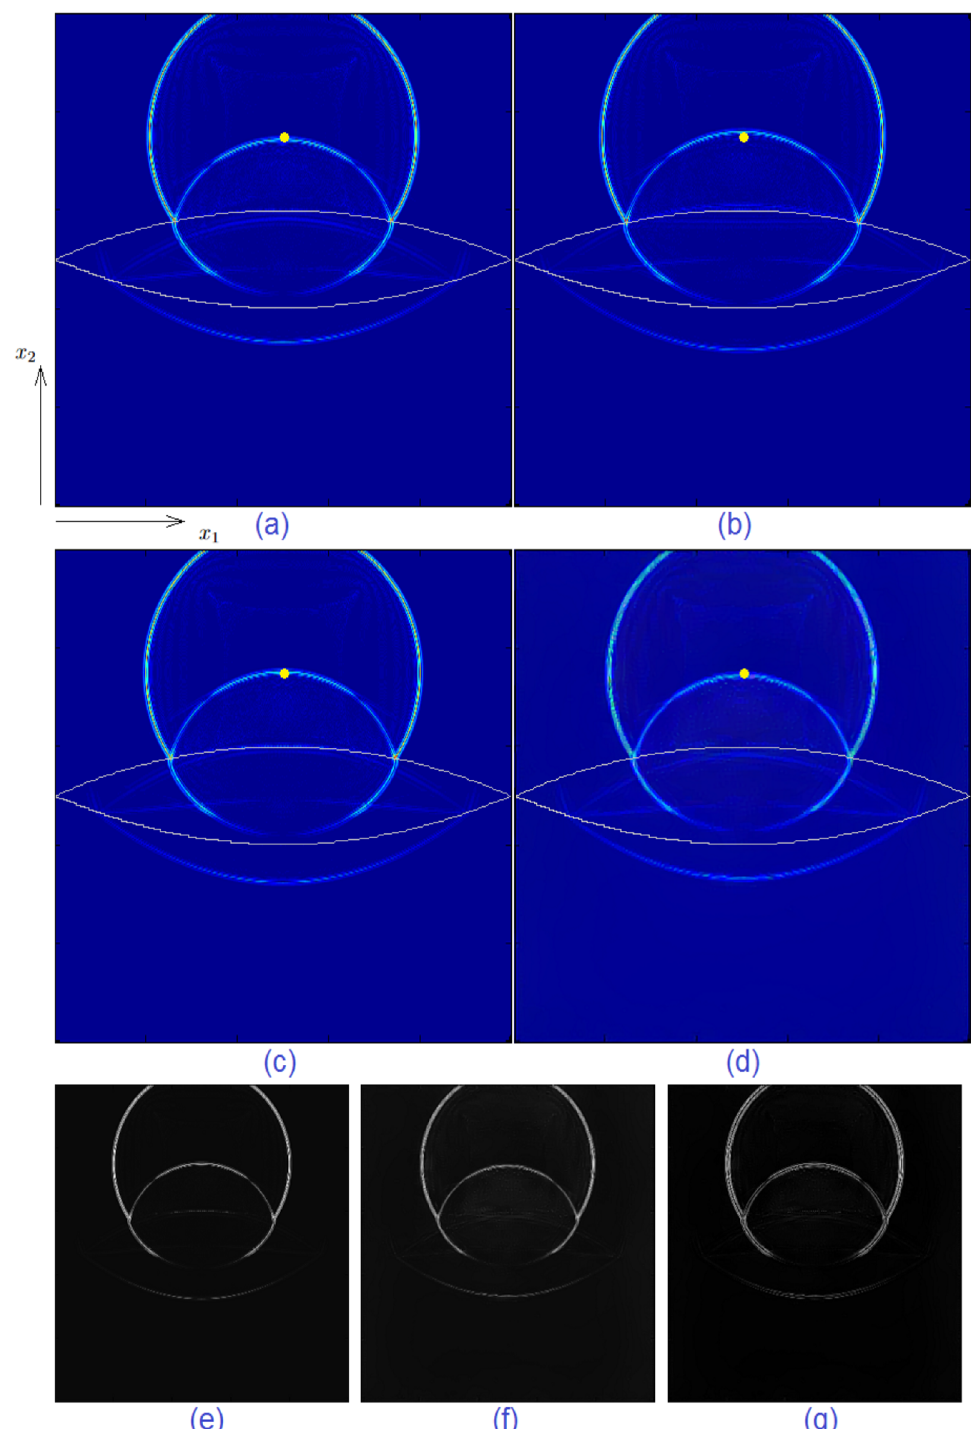
Fig. 8. Snapshot time from t =190 m s (a), t =200 m s (b), and t = 195 m s (c), for the radiation pattern of a point force (directed along x 2 ) generating a Ricker pulse with central frequency 250kHz and spectral bandwidth 10kHz, located at 12.5 cm from the top and 25cm from the left and the right edge of a fi eld of 50 cm by 50cm, applied to the “ Lens 2 ” ; style transfer result (d) between (a) and (b), (e) is (c) transformed in a grayscale image, (f) is (d) transformed in a grayscale image and (g) is the absolute value of the difference between (e) and